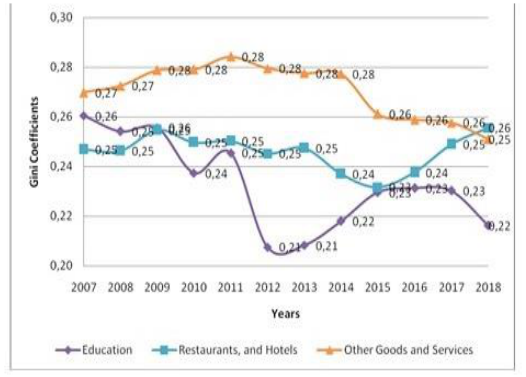
Figure 5. The Course of Gini Coefficients of Inequalities of Expenditure Rates at NUTS-2 Level Regions between